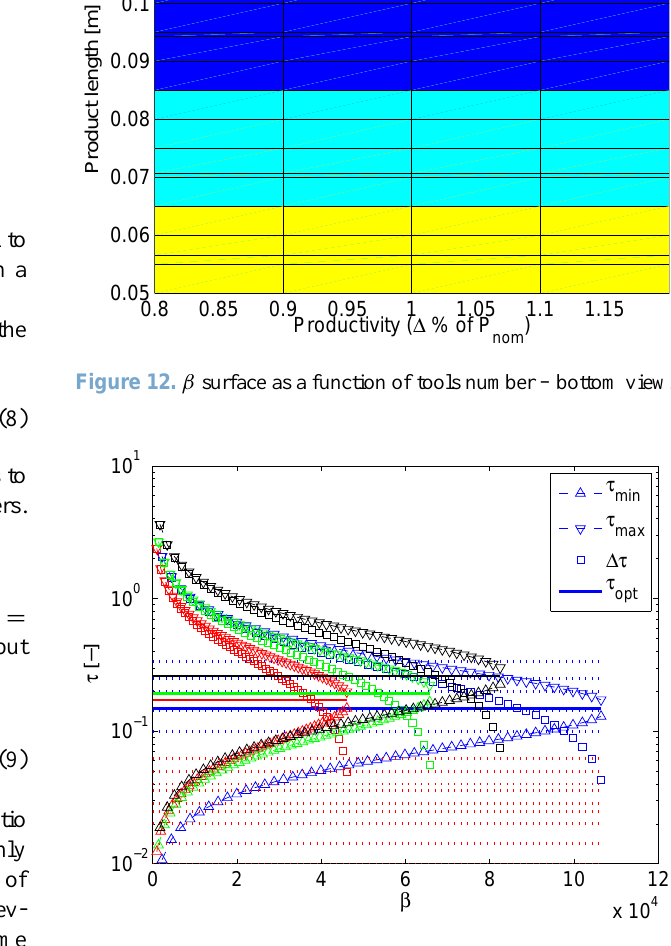
Figure 13. τ as a function of load factor β for four different motors.